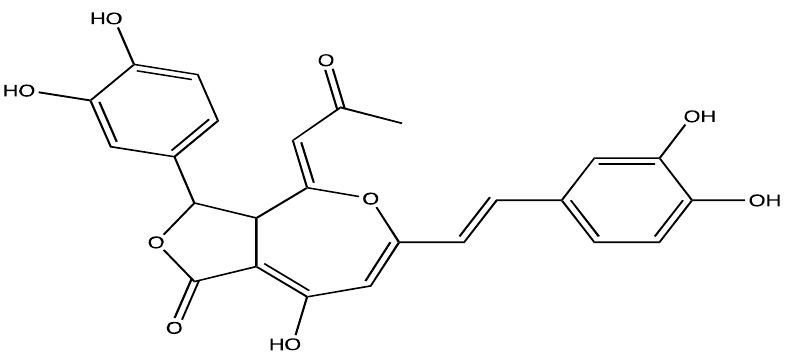
Figure 18. Structure of davallialactone isolated from Inonotus xeranticus mushroom. Additionally, ethanolic extract of Hypsizygus marmoreus (white beech mushroom) markedly inhibited rat isolated platelet aggregation, ATP release and intracellular Ca 2+ levels after activation with 1 µg/mL collagen, although it did not affect platelet activation by ADP (5 µM) or thrombin (0.05 U/mL) [161]. The ethanolic extract of Cordyceps militaris mushroom reduced rat PRP aggregation induced by 10 µM ADP and collagen 5 µg/mL in